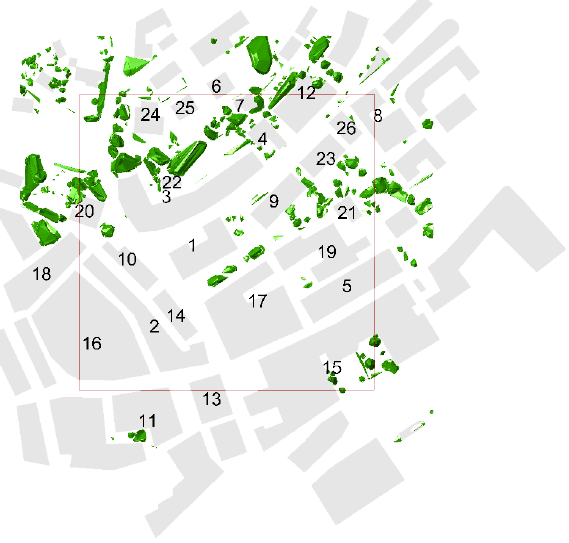
Figure 2. Plan of tile 204. The simulated sensor points are con- tained in the square.